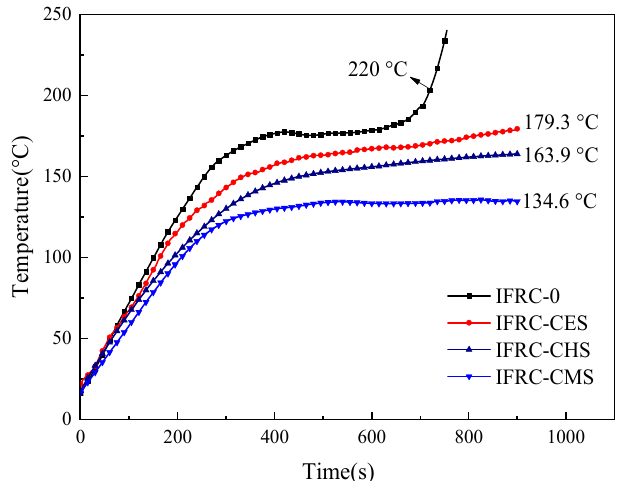
Figure 5. Backside temperature curves of IFRCs assessed by the big panel method